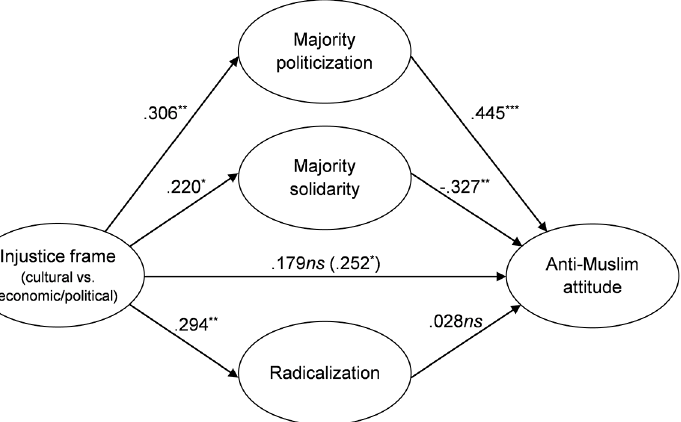
Figure 1. Effect of injustice frame on anti-Muslim attitude as mediated simultaneously by majority politicization and majority solidarity, but not radicalization (Experiment 1). Coefficients represent standardized regression weights. The regression weight from the regression analysis without the mediators is given in